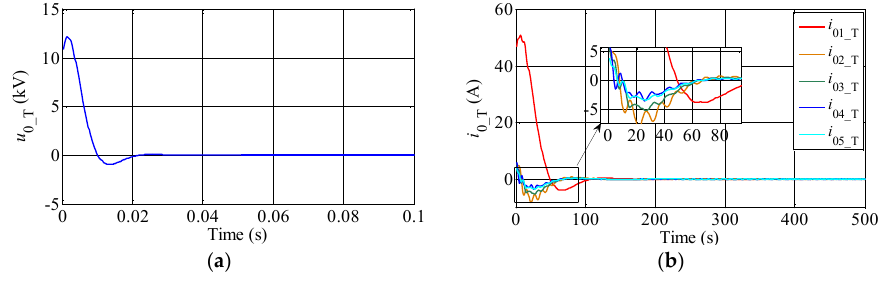
Figure 4. Transient components of bus zero-sequence voltage and feeders’ zero-sequence currents for a single-phase HIF in K1 point. ( a ) Transient component of bus zero-sequence voltage; and ( b ) Transient components of feeders’ zero-sequence currents.